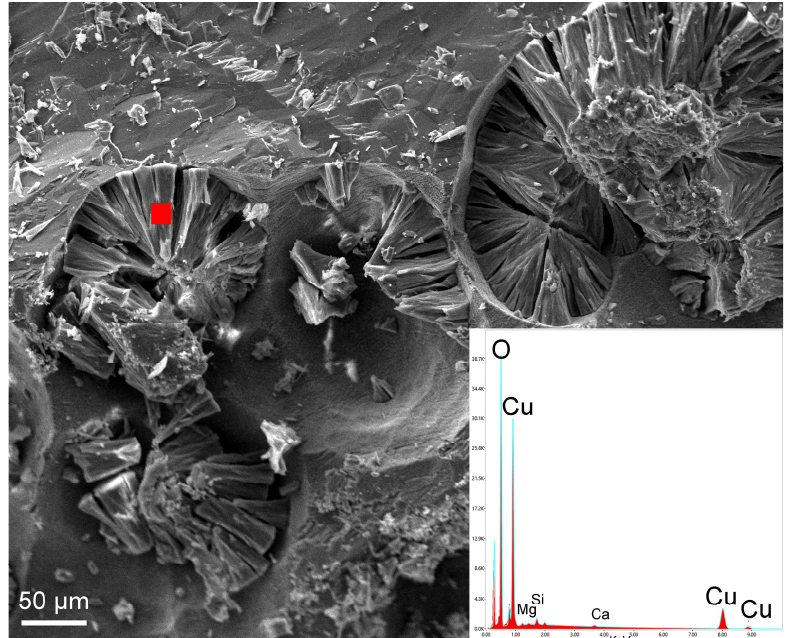
Figure 15. SEM image and corresponding EDS spot analysis (red filled square) of malachite crystals from the Mastricarro Barite Mine (Catanzaro, southern Italy).